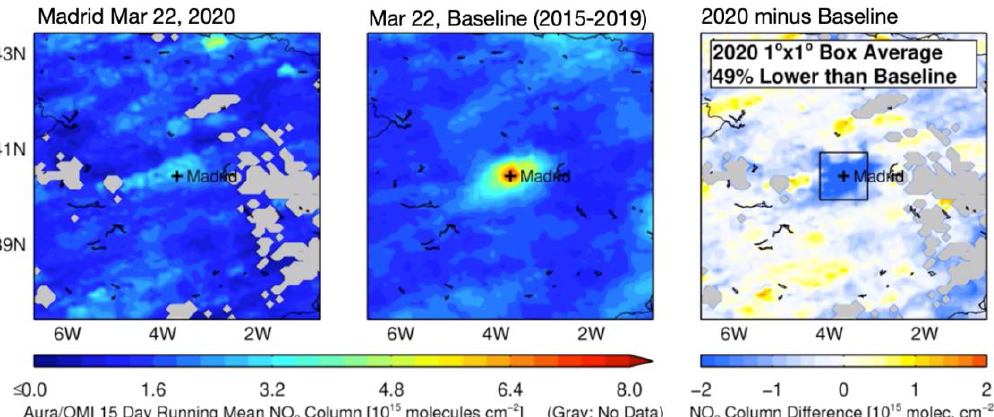
Figure 8. Mobility evolution in Madrid from January until September 2020. Source: Own elabora- tion with data collected from Apple ’s mobility trend [22].